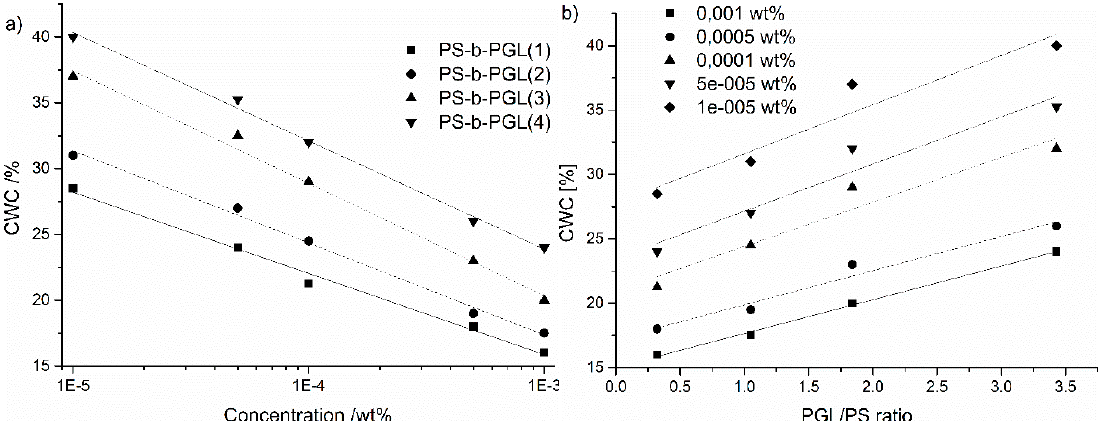
Figure 4. ( a ) CWC of copolymer solutions as a function of the initial concentration of the polymer in dioxane ( b ) CWC of copolymer solutions as a function of PGL/PS ratios for different initial concentrations.